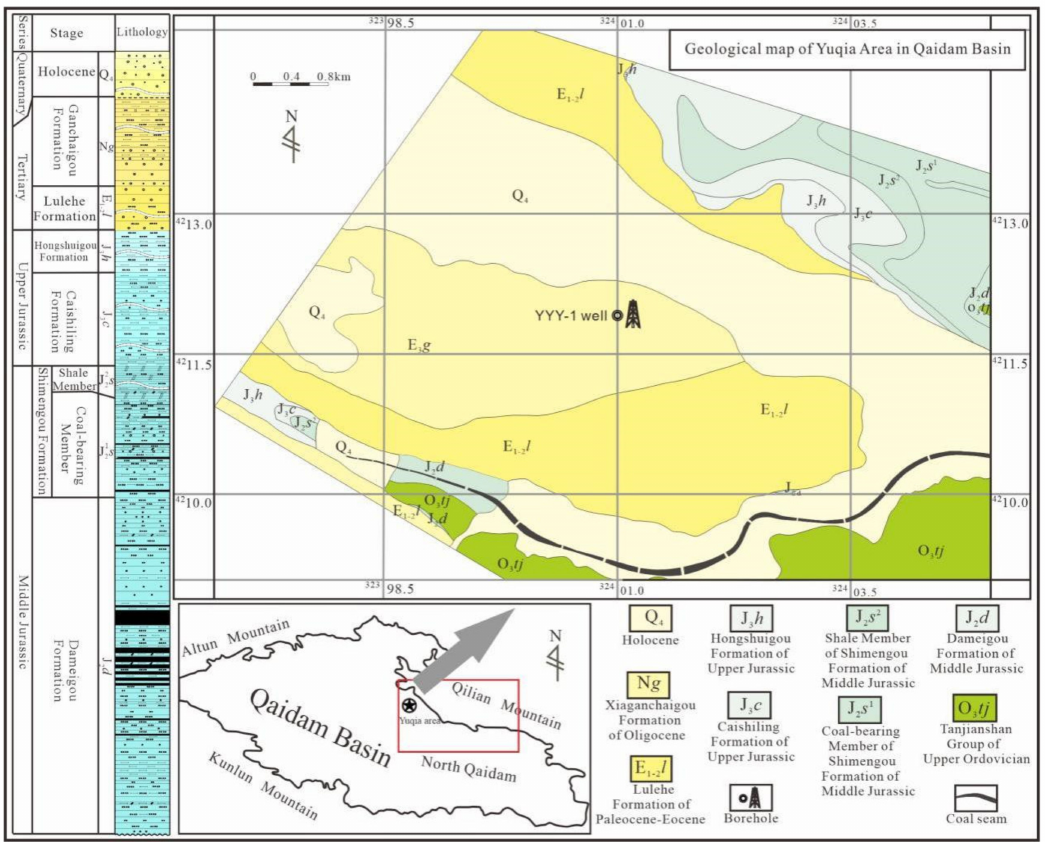
Figure 1. Geological map of the Yuqia Area in the Qaidam Basin, China, showing the location of the YYY-1 well (modified from